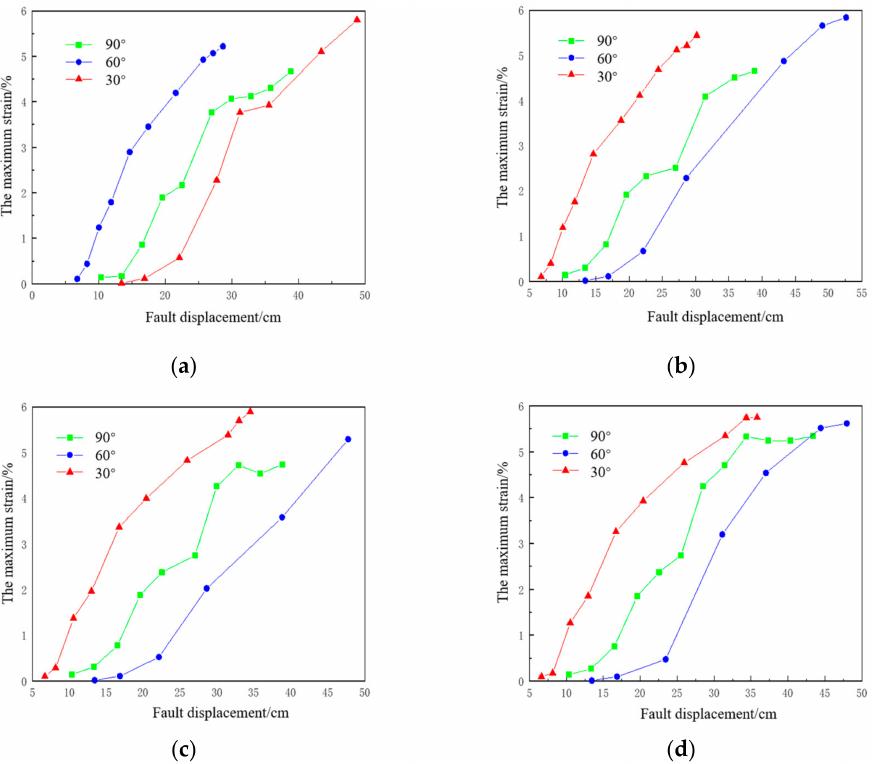
Figure 13. The maximum strain change law of pipeline under different included angles: ( a ) 219.1 × 6.0;